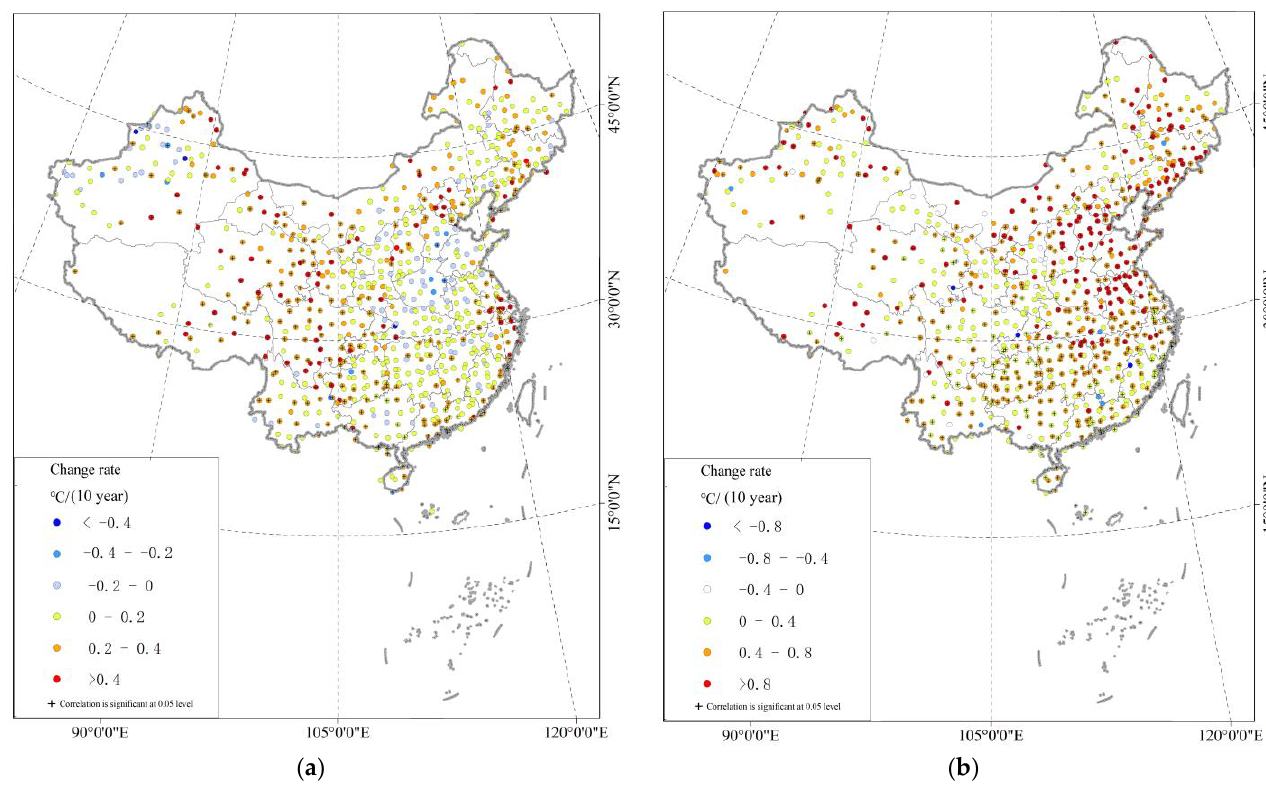
Figure 5. Spatial distribution of changes in TXx and TNn, 1966 – 2015. ( a ) TXx. ( b ) TNn.